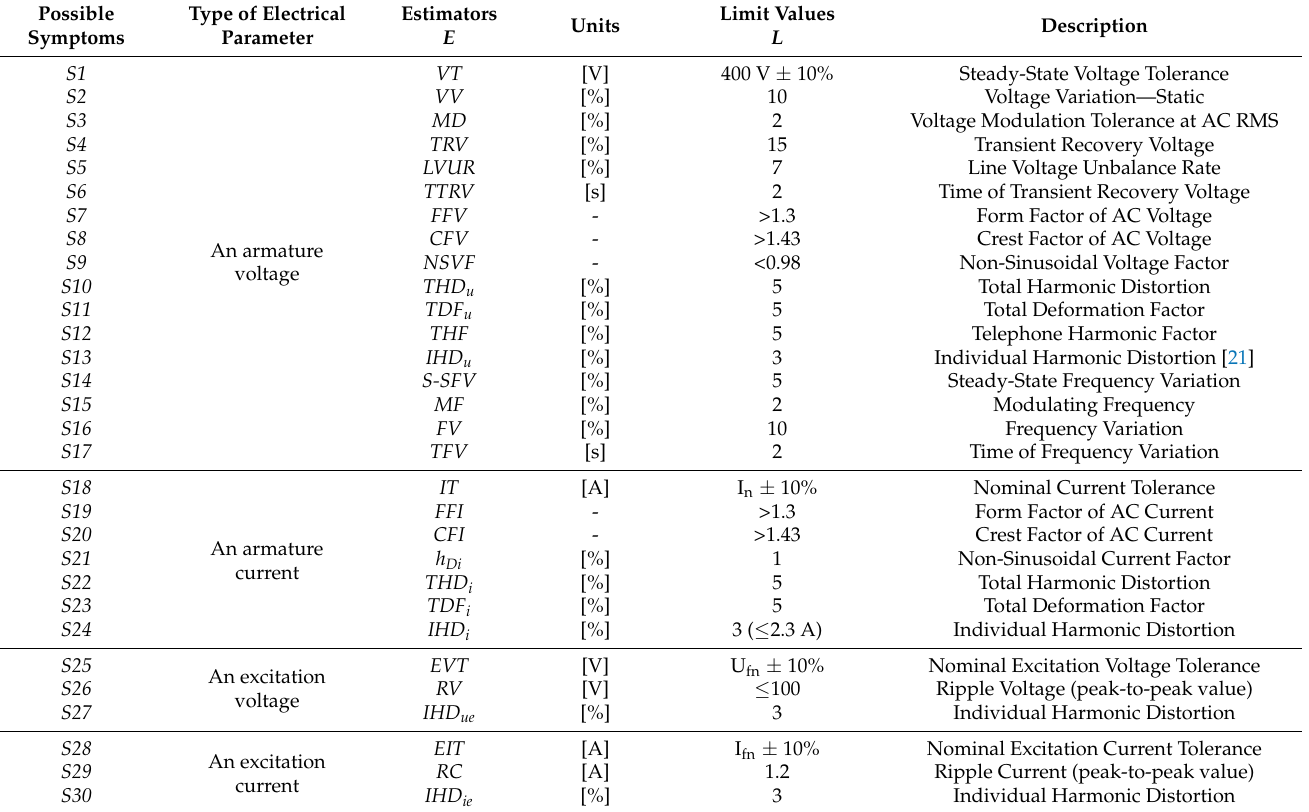
Table 2. Table of the failures, symptoms, estimators, and their limit values. Possible Type of Electrical Symptoms